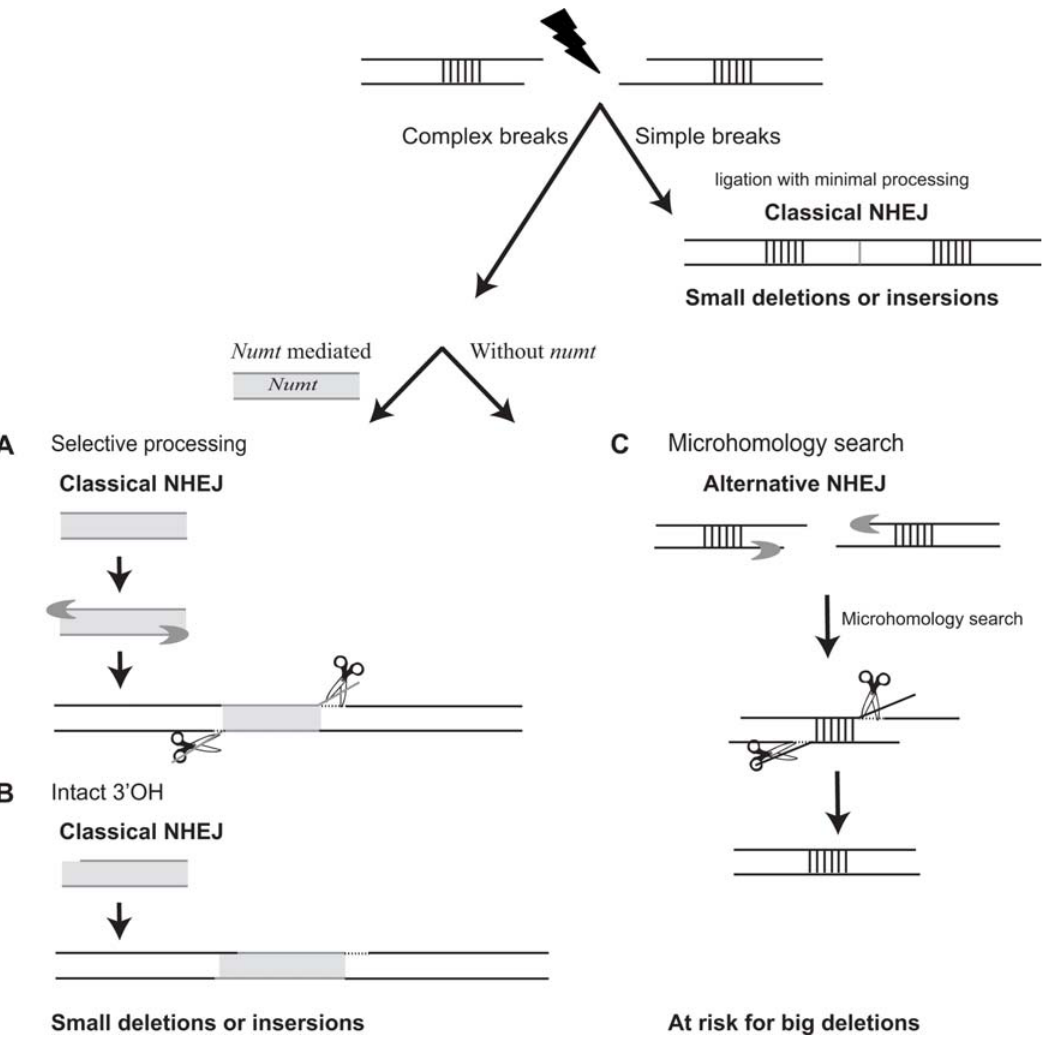
Figure 5. Sealing DSBs with numts reduces the risk of deleterious DSBR–a model for protective filler DNAs. DSBs can vary in their chemical complexity, simple breaks are breaks in which the phosphoester bond is broken but neither the sugar nor the nucleotides in the vicinity of the breaks are damaged. In contrast, complex breaks include fragmented sugar and damaged or missing bases in the vicinity of the break. While simple DSBs like experimentally induced ones are repaired with minimal processing, repair of complex DSBs can sometimes be deleterious. We propose that numts can seal complex DSBs and thus reduce the risk for deleterious repair. At least two mechanisms may explain how numts , and probably other filler DNA, prevent chromosomal deletions. (A) Numts prevent deletions if they undergo selective processing that enables them to seal the broken chromosome. For example, if exposure of long single-strand DNA occurs only in the numt sequence, numt -genome repair mediated by microhomology (dots) can be accomplished even if very short chromosomal single-stranded DNA is exposed at the immediate vicinity of the break. Thus, only non-matching mitochondrial DNA will be removed. (B) Alternatively, some breaks may contain degraded 3 9 OH in both sides. Numts can supply the intact 3 9 OH to perform ligation with no need for nuclease processing. (C) In the absence of filler DNA (i.e., numts ), repair of complex DSBs may not occur in the immediate vicinity of DSB, but instead single-stranded DNA is exposed followed by a search for microhomology between the two sides of the breaks (marked here in strips). When microhomology is found, the two sides of the breaks are annealed, and non-complementary single-strand DNA is trimmed off (scissors) to yield a deletion in the chromosome. Dotted lines represent DNA synthesis and crescent-shaped blobs represent